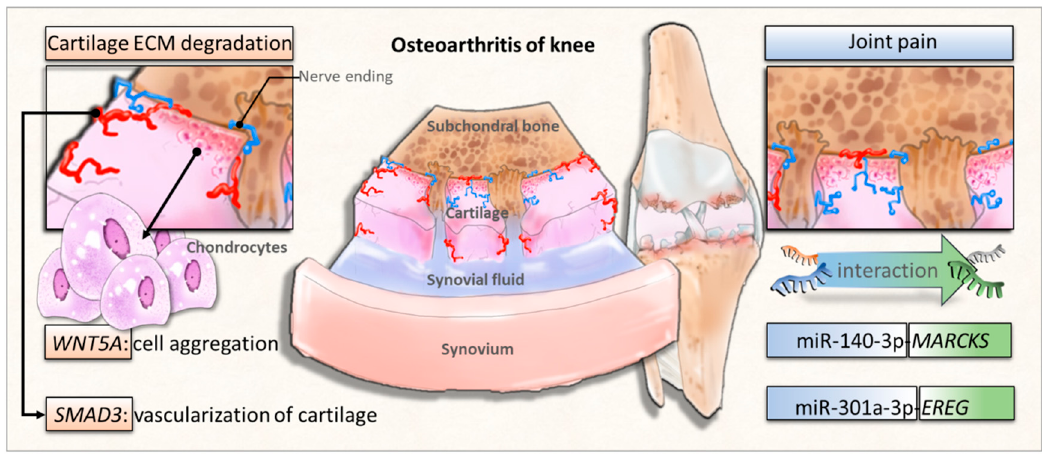
Figure 9. The proposed novel molecular signatures and miRNA regulations in osteoarthritic knee chondrocytes.